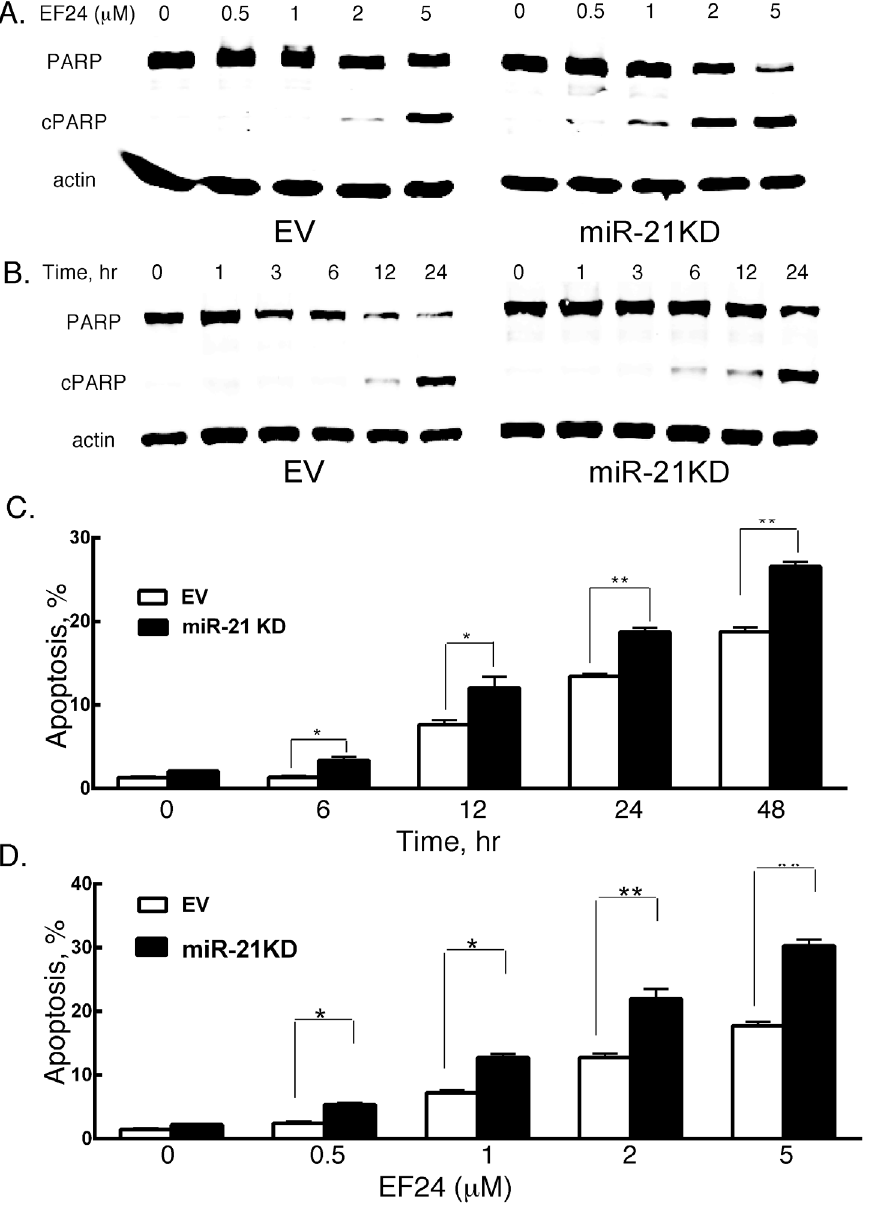
Figure 1. The effects of EF24 and miR-21 KD on apoptosis invitro . EV and miR-21KD DU145 cells were treated with EF24 (A) at varying concentrations for 24 hr or (B) at 5 m M for varying times, and the extent of PARP cleavage (cPARP) as a measure of apoptosis was determined by immunoblotting with anti-PARP. EV and miR-21KD B16 cells were treated with EF24 (C) at 5 m M for varying times or (D) at varying concentrations for 48 hr, and the fraction of annexin V positive cells was determined by flow